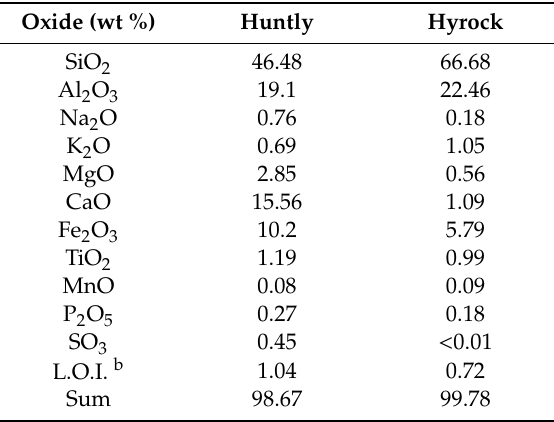
Table 4. Chemical composition of the fly ashes a .